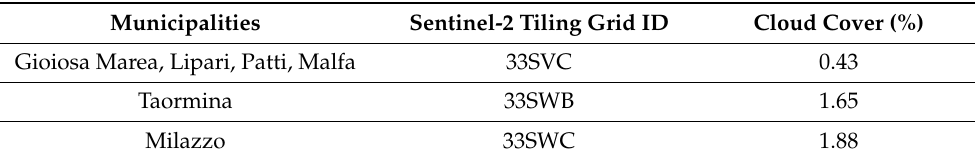
Table 2. Sentinel-2 imagery analyzed for land use on PBs of the province of Messina. Three images acquired on 20 October 2019 at 05:50:29 UTC by Sentinel-2B satellite were analyzed for land use/land cover mapping of the PBs located in six municipalities of the province of Messina. These images cover three tiling grids for each municipality with cloud cover percentage varying from 0.43 to 1.88. Four bands (blue, green, red, and near infrared) with a spatial resolution of 10 m were used. Municipalities Cloud Cover (%)